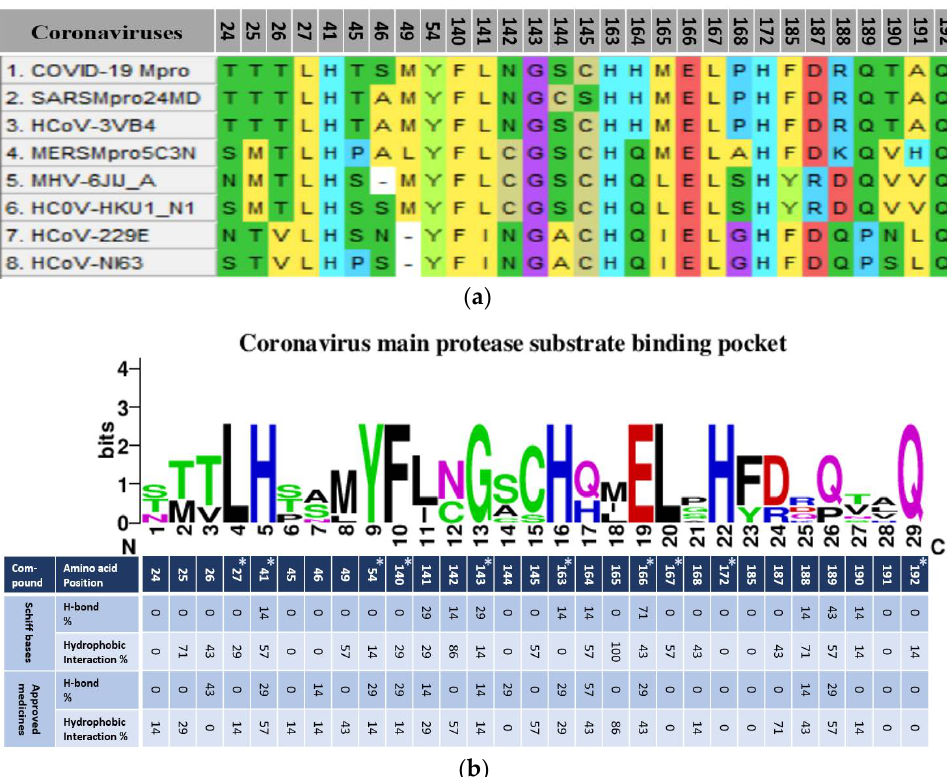
Figure 10. ( a ) Alignment of amino acid constructing coronavirus substrate-binding pockets in the M pro . ( b ) A WebLogo analysis of amino acid residues constructing the substrate-binding pocket consensus of coronaviruses’M Pro . The table runs parallelly with the amino acid consensus, showing the percentage calculated for H-bonds and hydrophobic interactions resulting from in silico studies using protein docking. Results were carried out for two groups of ligands, the newly synthesized SBs, and the approved medicines used to treat COVID-19.